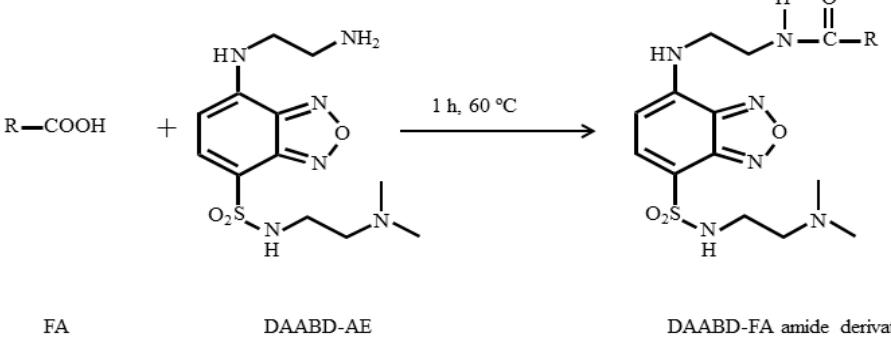
Figure 1. DAABD-fatty acids (FAs) amide derivative obtained by derivatizing FAs with DAABD-AE.